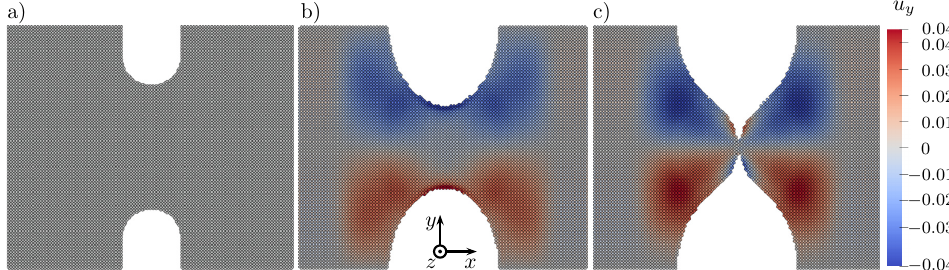
Figure 3. Discrete atom displacement field. The images show the displacement component u y along the y-axis at ( a ) the initial state, ( b ) an intermediate state and ( c ) the final state.